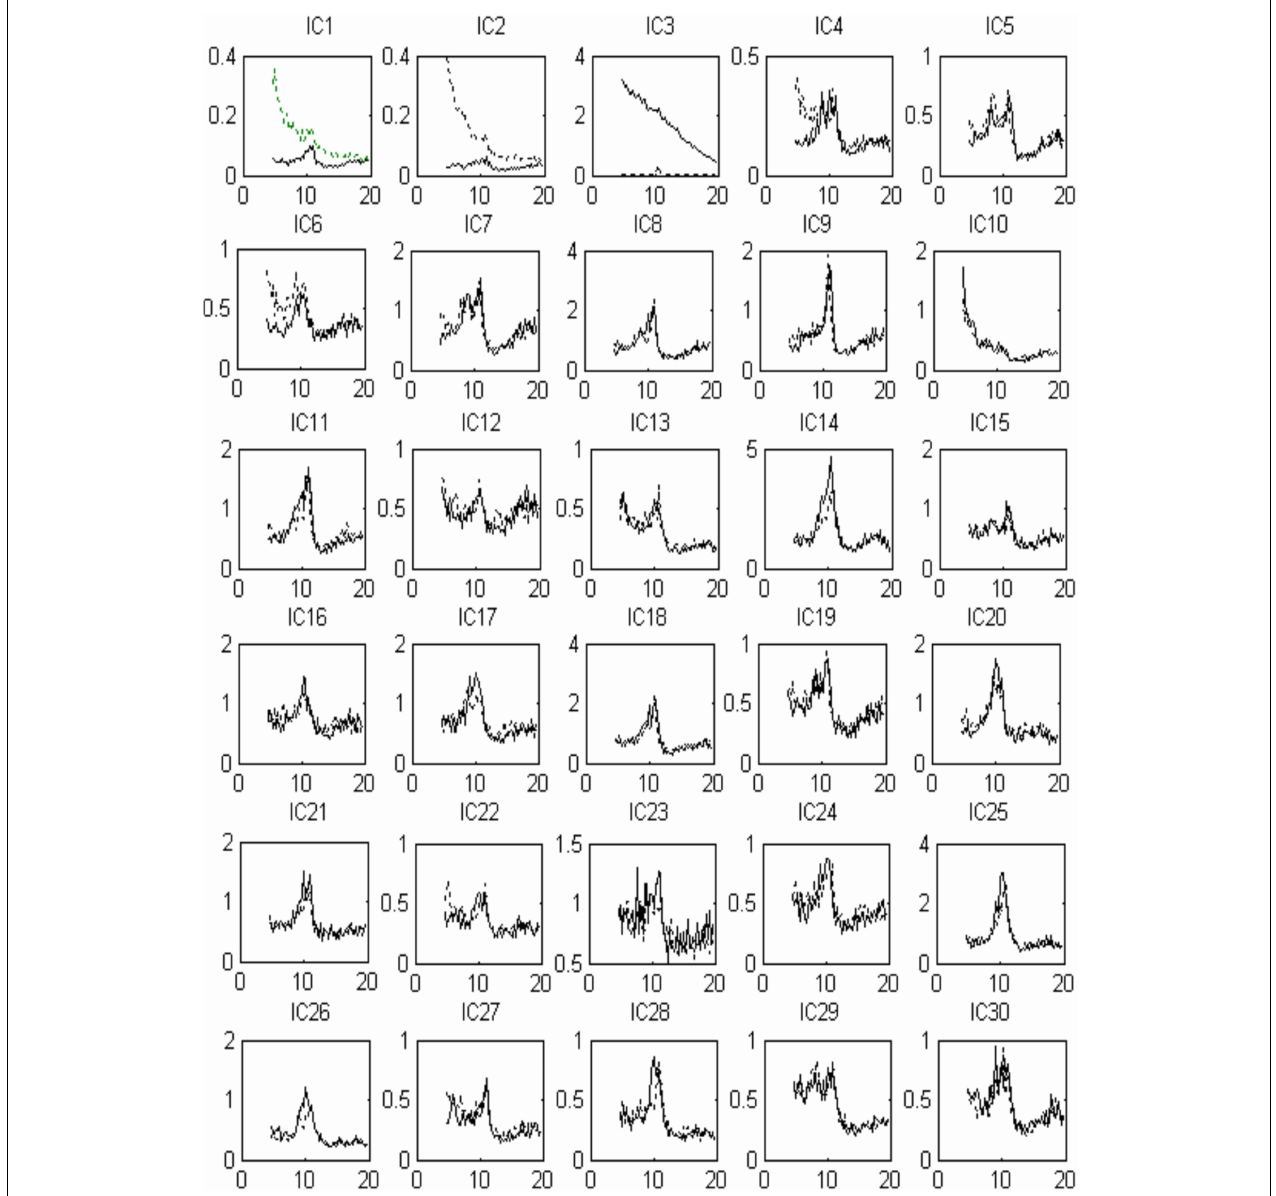
FIGURE 6 | Source signal power spectra curve corresponding to Figure 5: x-coordinate for frequenc y (Hz), y-coordinate for power spectrum ( u V 2 ). The solid line indicates pre-learning, and the dotted line indicates post-learning.